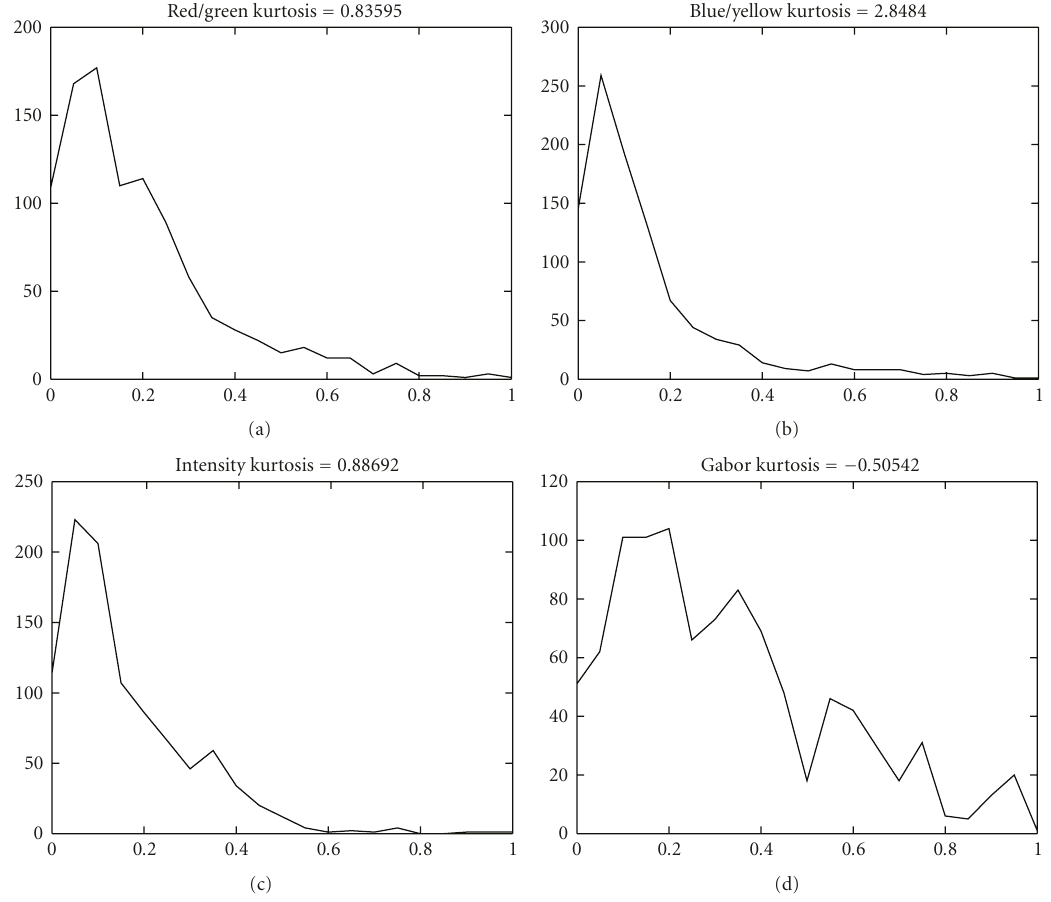
Figure 4: The histograms and the estimated kurtosis for the conspicuity maps.